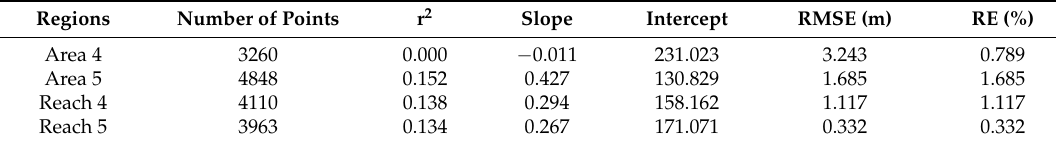
Table 2. Comparison of Geoswath bathymetry and ADCP data in the four selected regions. Regions